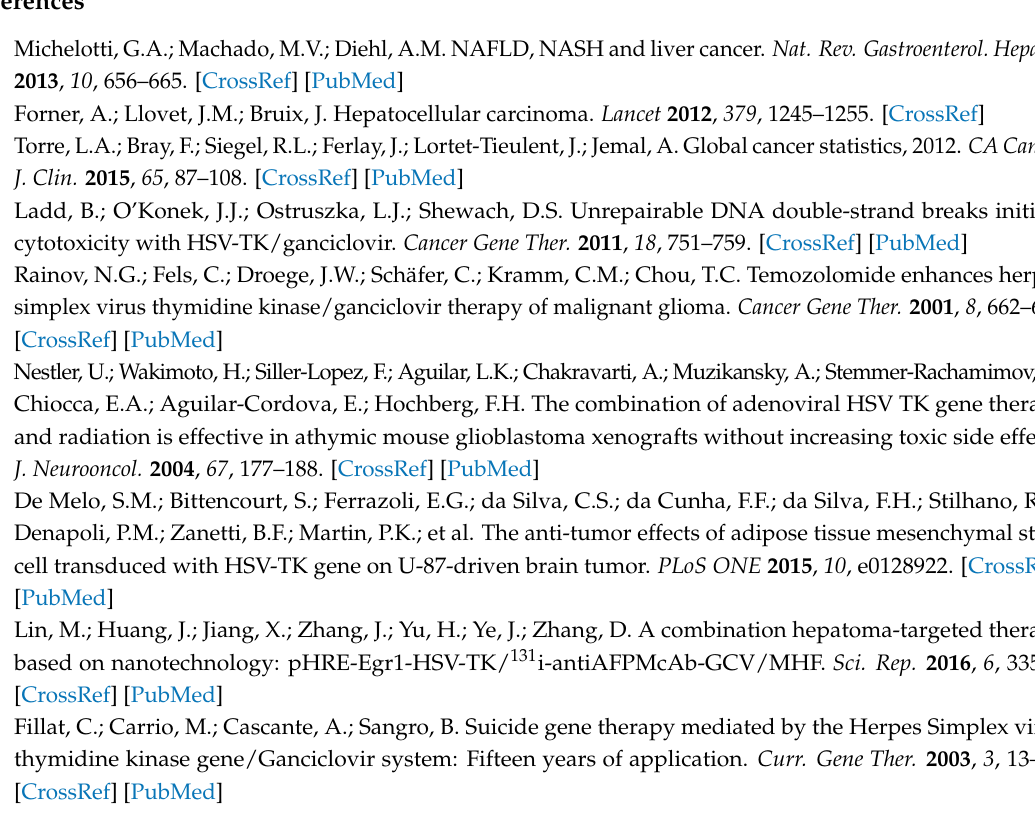
Figure S1: Immunohistochemistry analysis of different types of immune cell, Figure S2: Expression profiles of cell cycle related genes in TCGA HCC/LIHC patients, Figure S3: Expression profiles of Rufy3 and Pak1 in WT, hepatitis and tumor groups, Table S1: Overall health condition of mice included in transcriptome